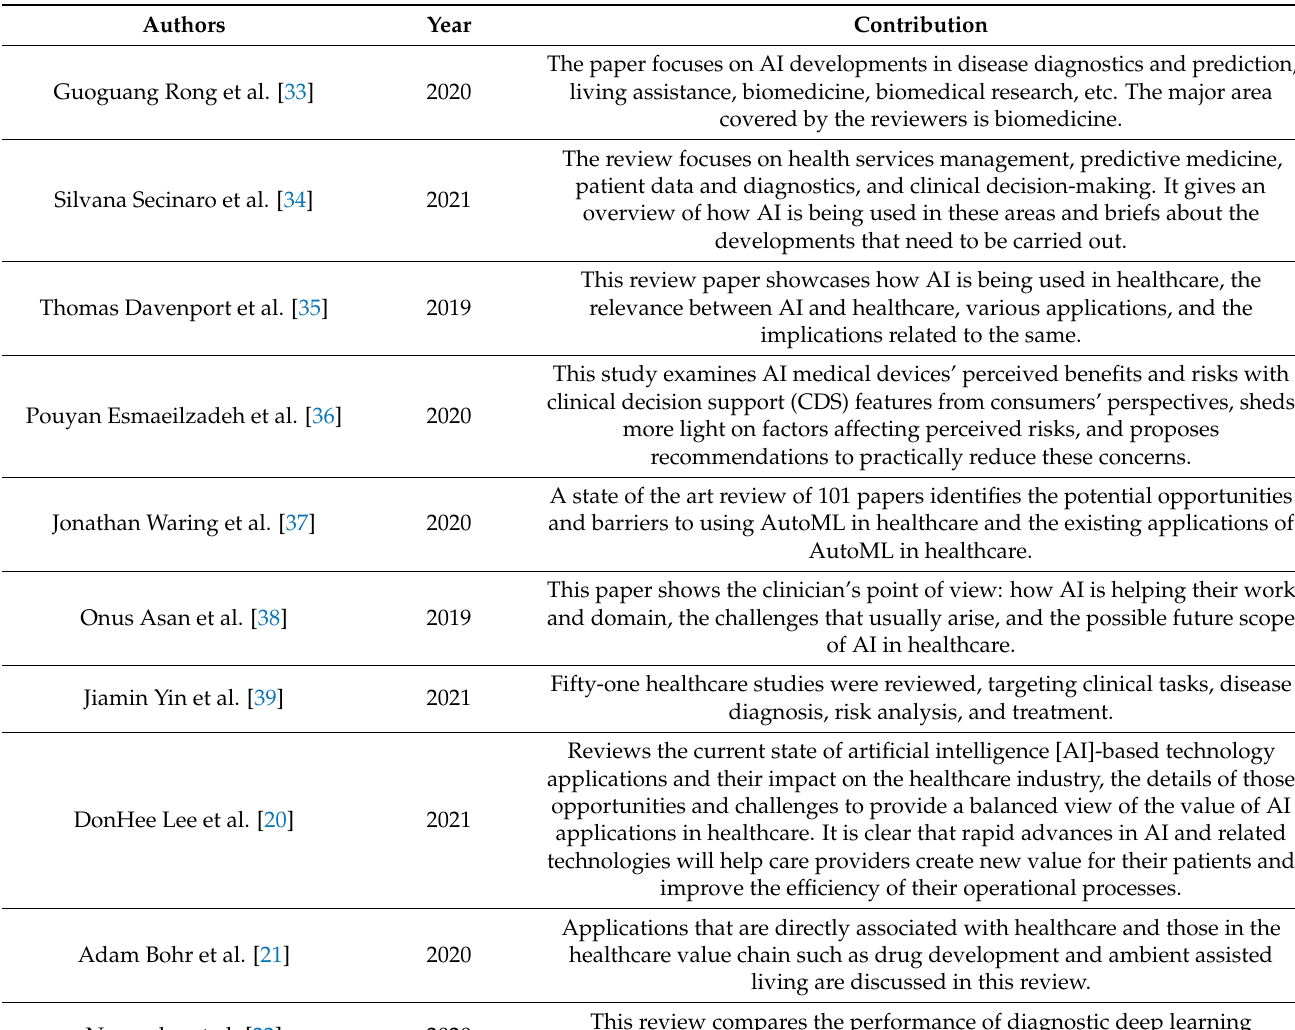
Table 2. Recent Contributions and Developments in AI in